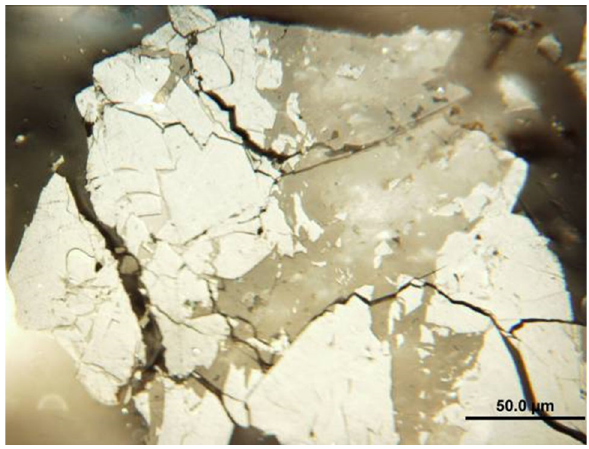
Fig. 12 A mylonite structure of low altered collotelinite ( R r =